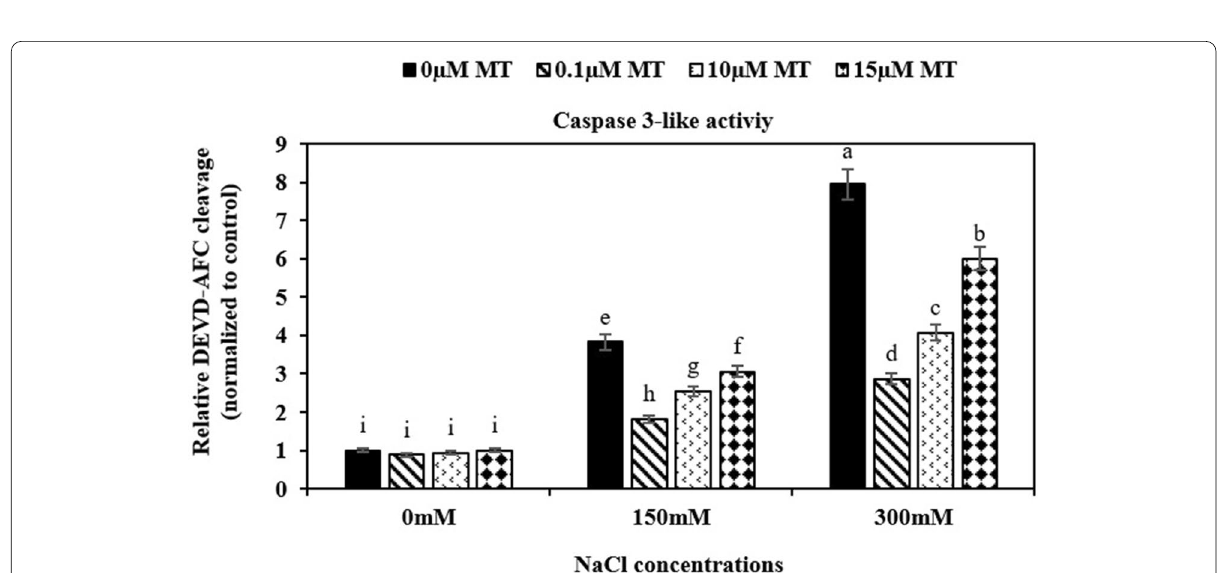
Fig. 4 Effect of melatonin on the activity of caspase-3 like proteases based on the cleavage of the substrate, DEVD-AFC. Data represents the mean of replicates SD and uncommon letters indicate significant differences based on Duncan’s multiple range test (P < ±